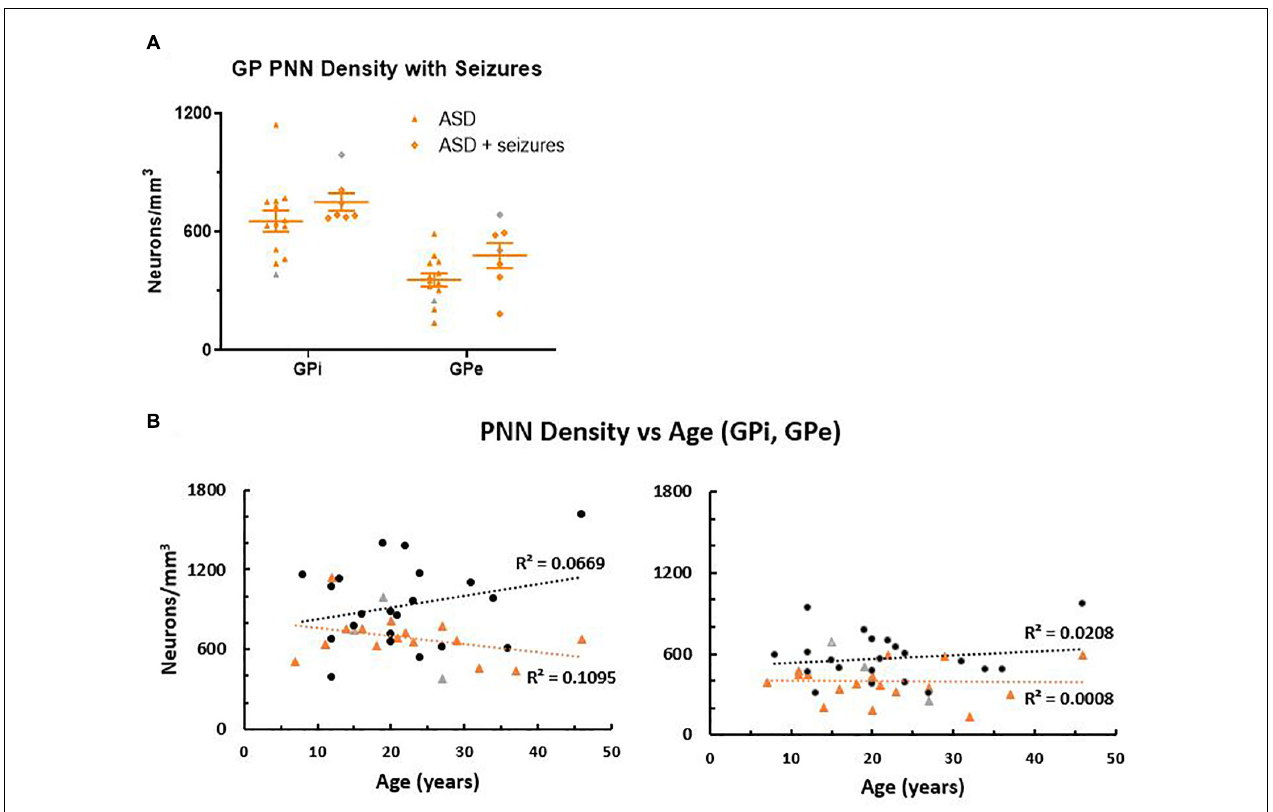
FIGURE 3 | (A) Autism spectrum disorder cases were separated into groups based on medical reports of seizure occurrence. In the globus pallidus (GP), all seven seizure cases had a diagnosis of epilepsy. Although the group means were not statistically different, the seizure cases trended toward higher perineuronal net density than the ASD cases with no history of seizures. (B) Perineuronal net density was plotted against age in both the GPi and GPe, which showed a positive correlation of density with age in the control group, but a negative correlation with age in the ASD group in the GPi, which was less pronounced in the GPe. However, slopes of the lines were not significantly different (GPi p = 0.093; GPe p = 0.57), but intercept (elevation) was significantly decreased in ASD for both the GPi ( p = 0.0048) and the GPe ( p = 0.0022) using a GraphPad Prism 7 model equivalent to analysis of covariance (ANCOVA), reflecting the decreased PNN density as a group. Females are identified as gray colored